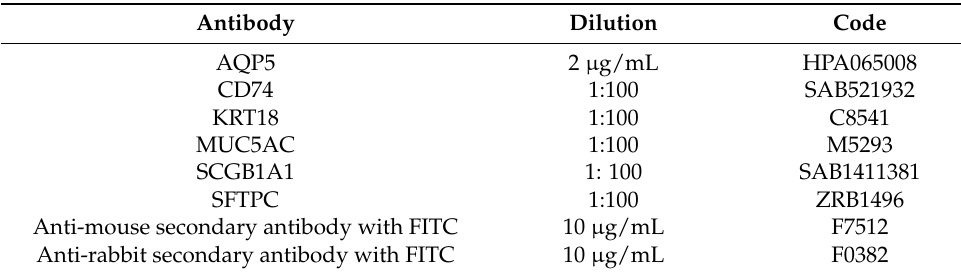
Table 3. Antibodies for